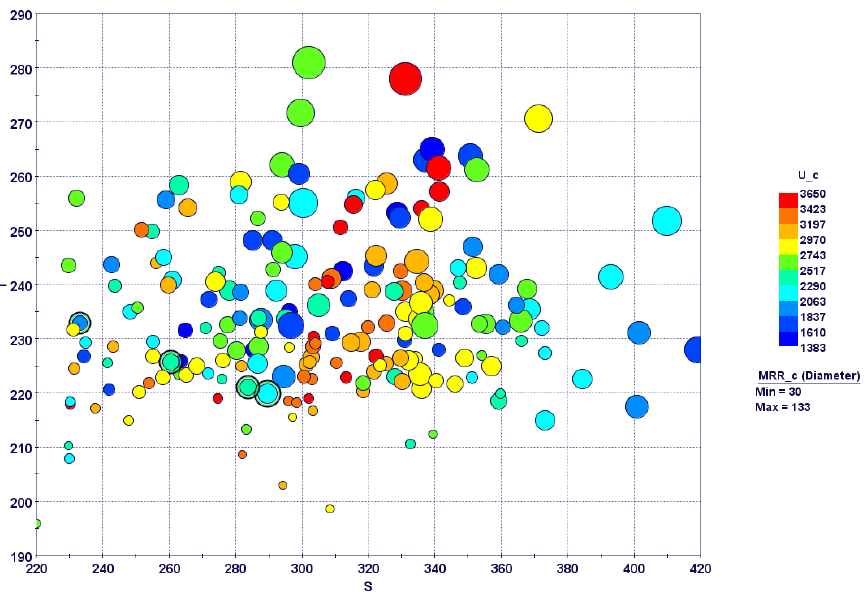
Figure 13. Four-dimensional bubble chart with optimum design points.